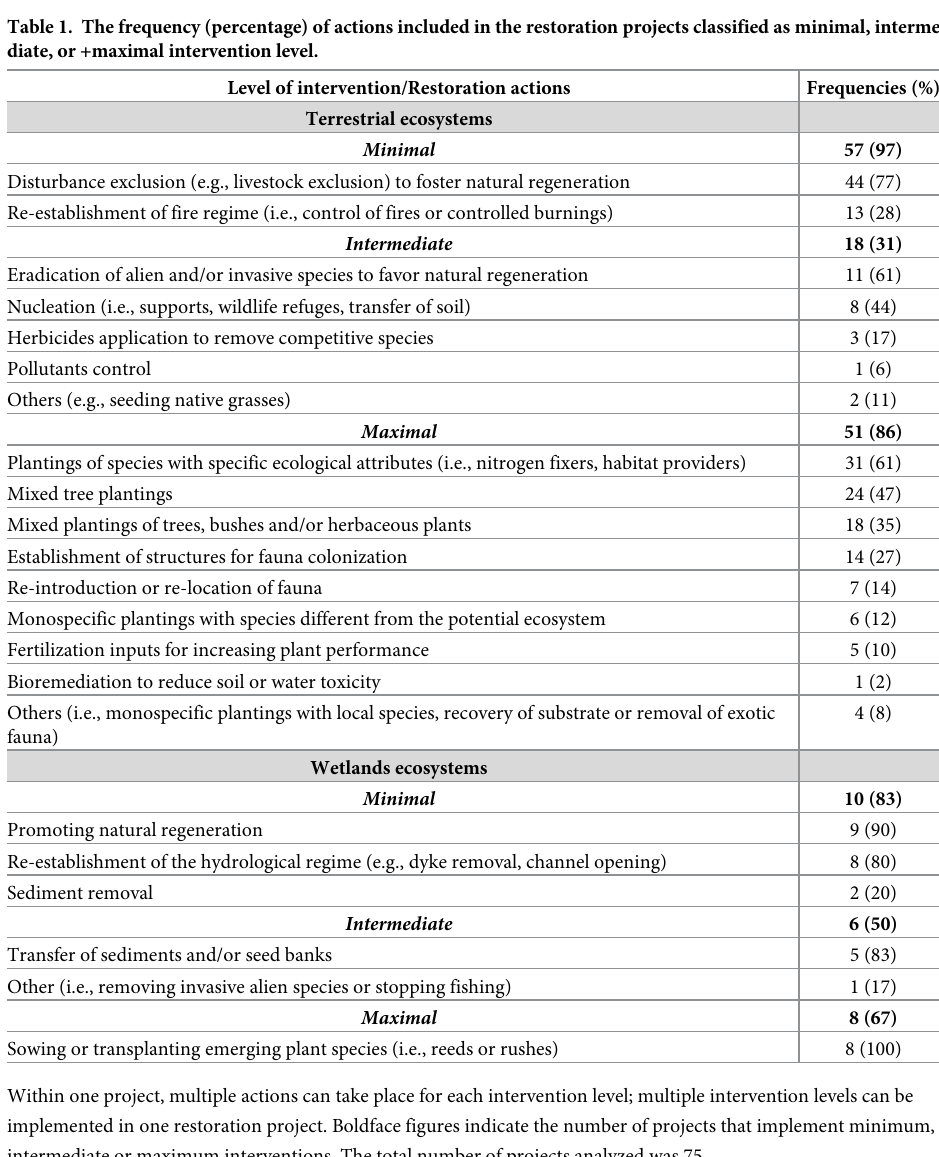
intermediate or maximum interventions. The total number of projects analyzed was